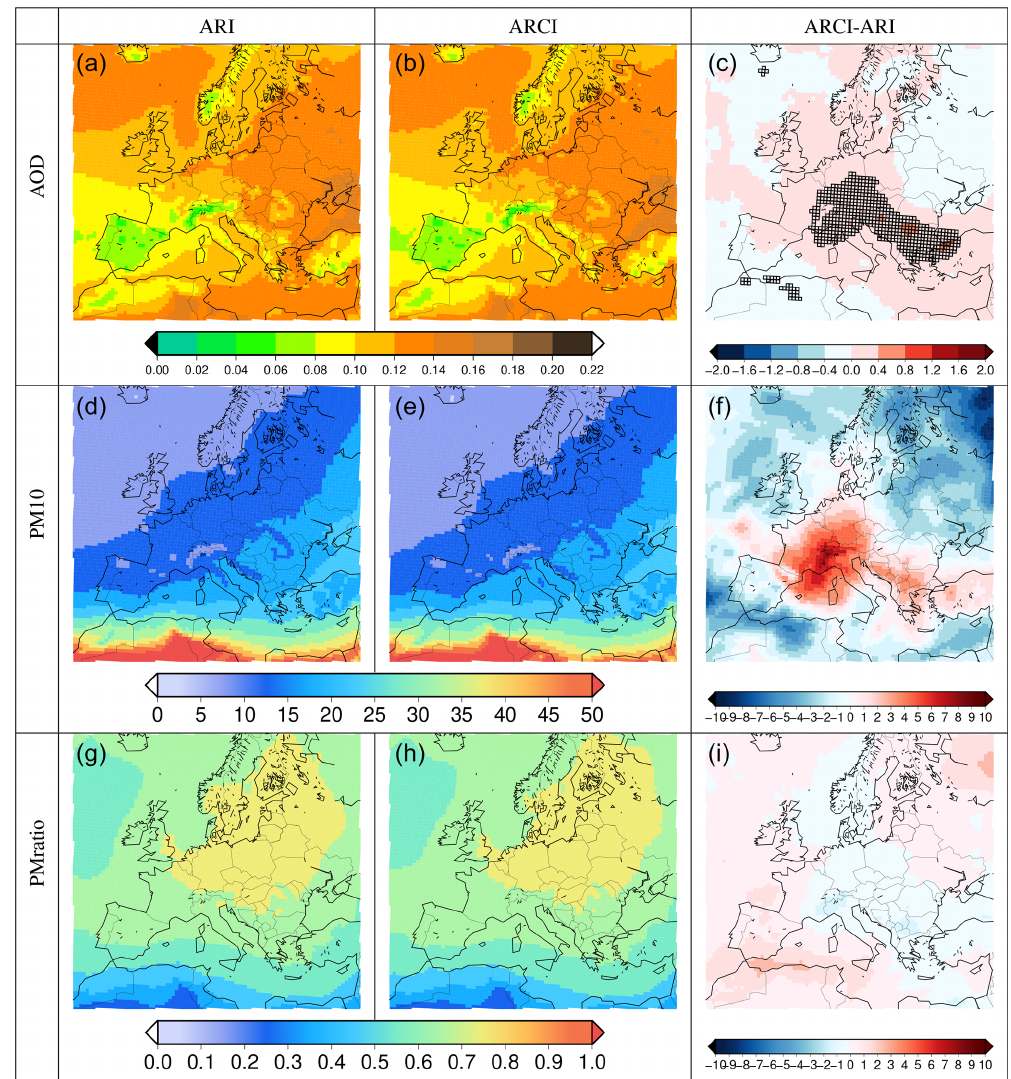
Figure 3. AOD, PM 10 (µgm − 3 ) and PM ratio mean annual values for ARI and ARCI and their differences (%).